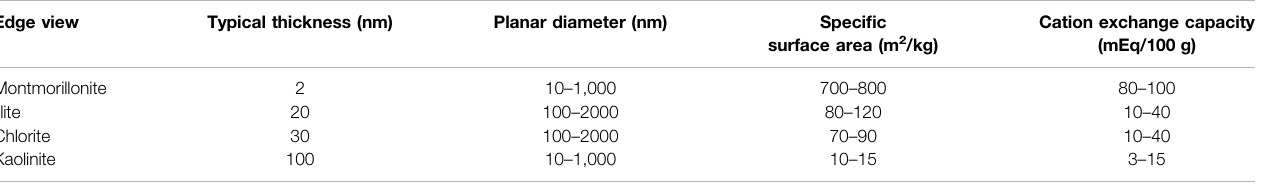
TABLE 4 | Typical values of thickness, planar diameter, speci fi c surface area and cation exchange capacity for common clay minerals (Yong et al., 2012).